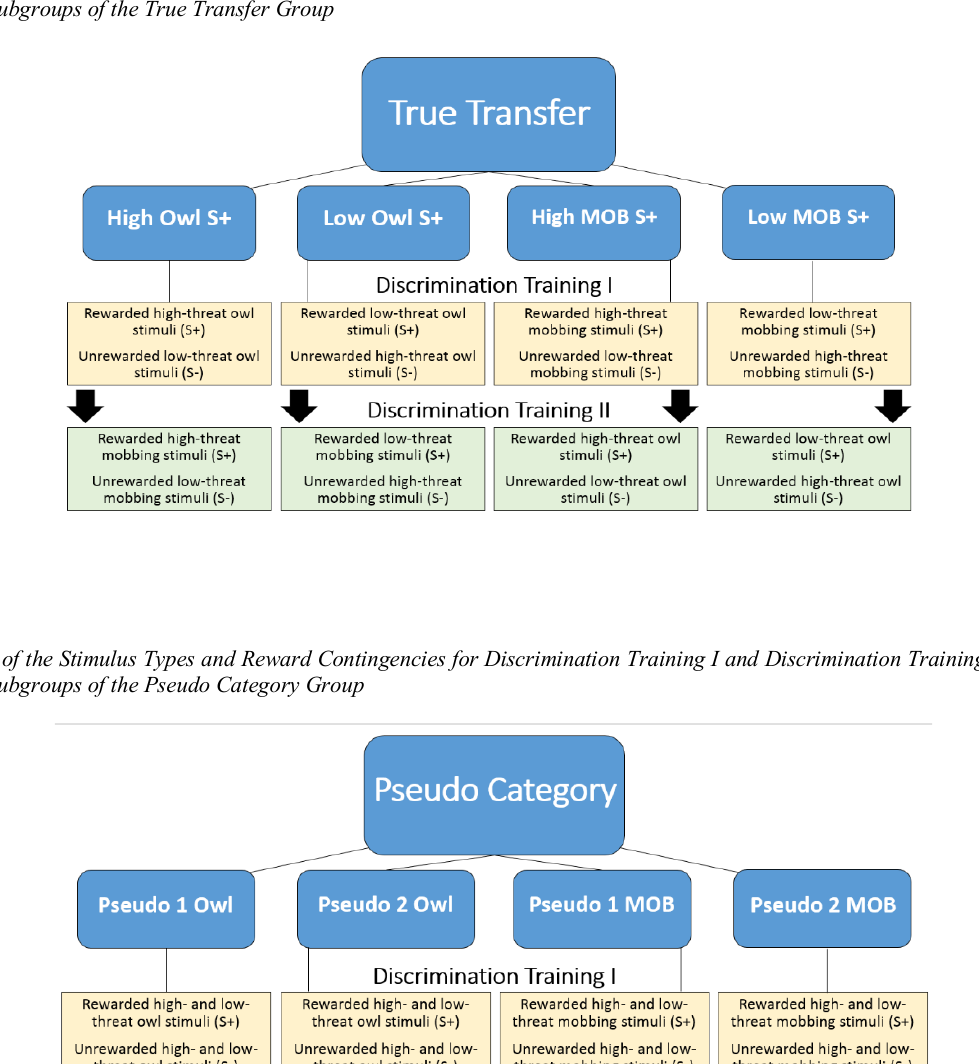
Schematic of the Stimulus Types and Reward Contingencies for Discrimination Training I and Discrimination Training II for the Four (4) Subgroups of the True Transfer Group